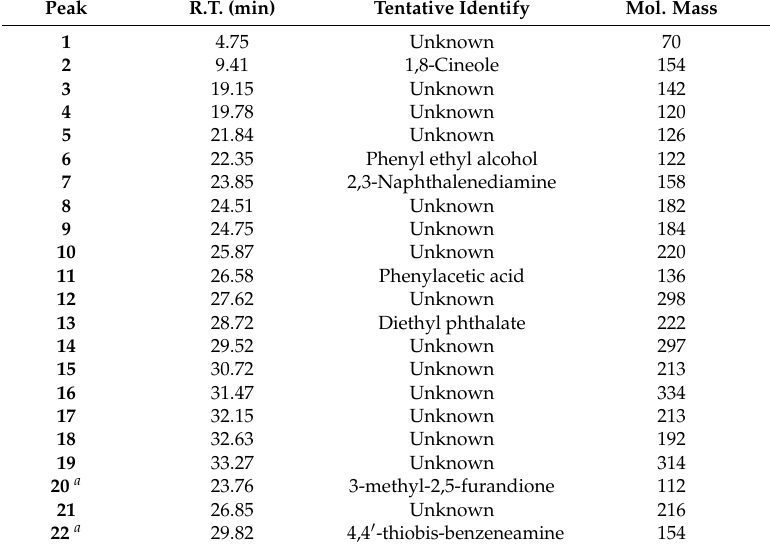
Figure 2. Gas chromatograms showing decreased VOCs production by BS15 after growing in vitro for several months ( bottom ). Adding BS15 to growth media (PDB) containing DCM extract/filter paper induced production of new compounds 20 , 21 , and 22 ( top ), and altered the production of compounds 6 and 18 . The middle plot demonstrates that filter paper containing no DCM extract also induces production of compounds 21 and 22 when included in growth media Nominal mass of each peak and their tentative identities are listed on Table 3. Table 3. Compounds detected by GC/MS from BS15 modified by treatment with DCM extract/filter paper. Peak R.T. (min) Mol.